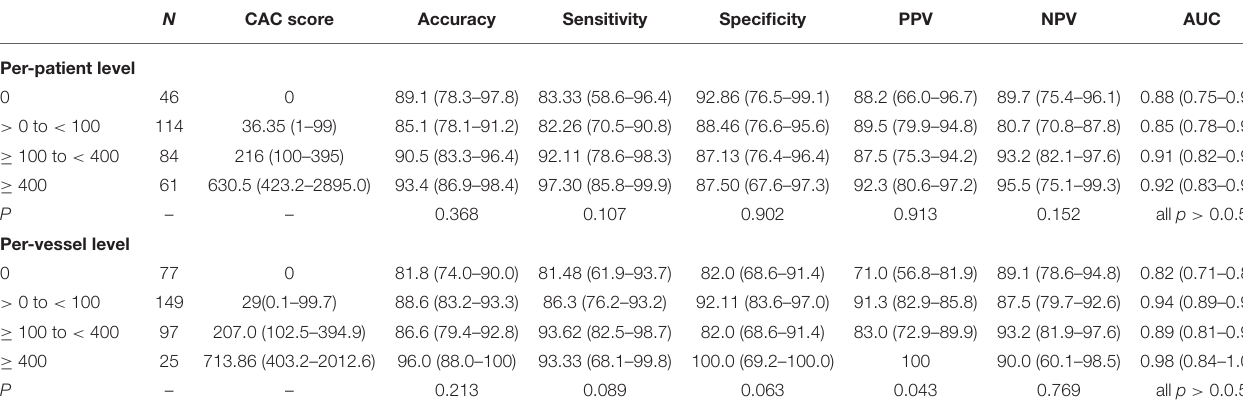
TABLE 3 | Diagnostic performance and accuracy of CT-FFR across CACs categories on per-patient and per-vessel level.